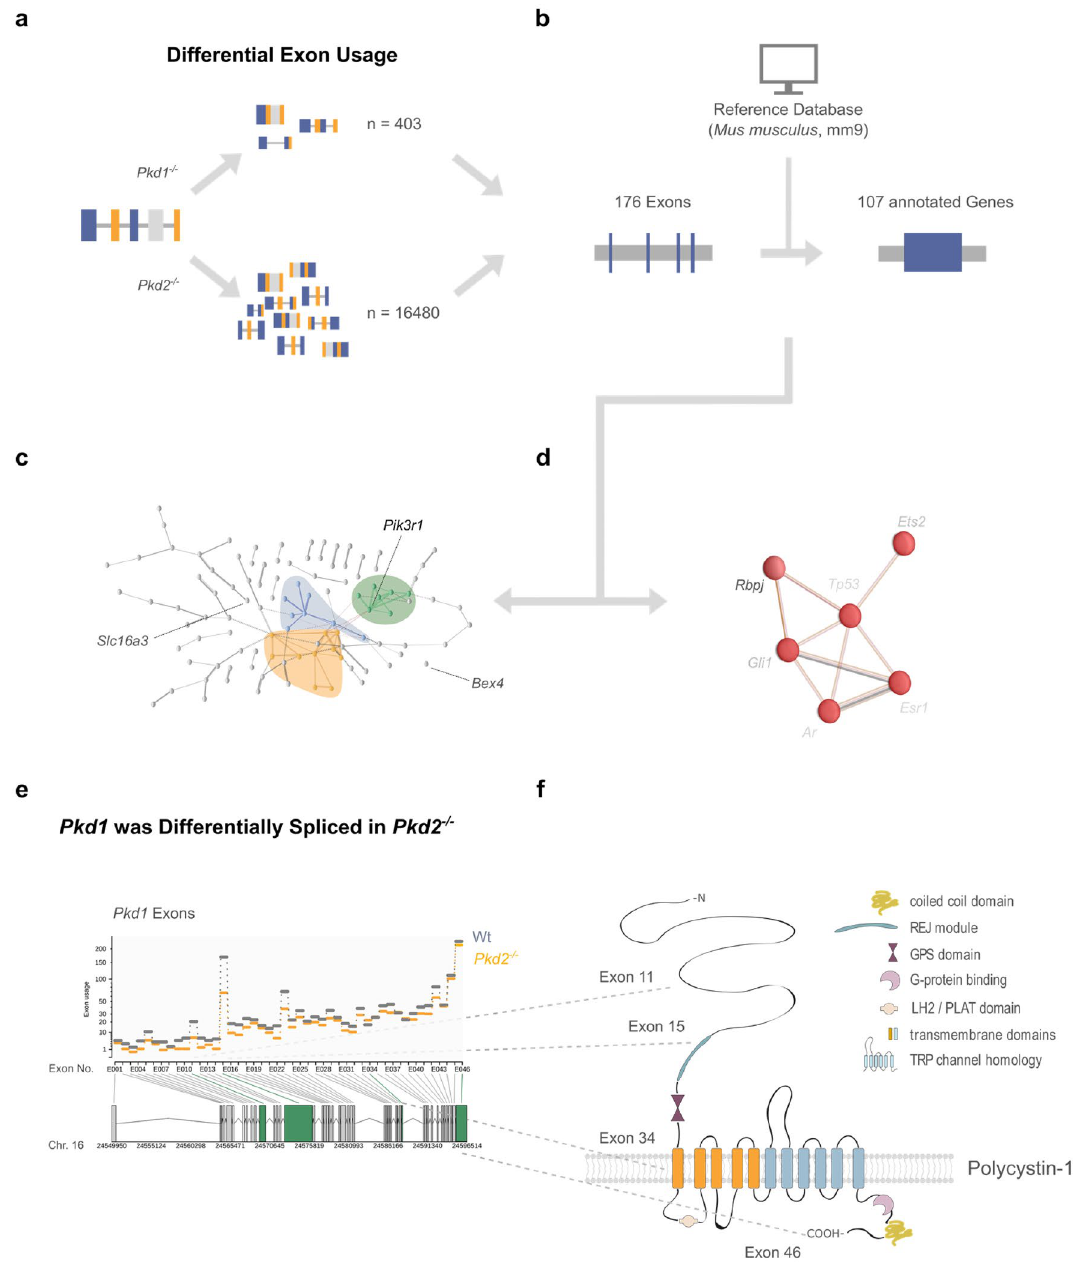
Figure 5. Loss of Pkd1 and Pkd2 caused significant alteration in exon usage, including differential splicing of Pkd1 . ( a ) Differential exon usage in Pkd1 −/− and Pkd2 −/− cells was assessed using DEXSeq 99,100 . Surprisingly, the number of transcripts with differential exon usage compared to wildtype was > 70-fold higher in Pkd2- deficient cells than in Pkd1 −/− cells (n = 16,480 vs. n = 403). ( b ) 176 differentially used exons overlapped between both genotypes. Identified exons mapped to 107 annotated genes and 39 genomic loci without annotation. 107 characterized genes are thus differentially spliced in Pkd1 −/− and Pkd2 −/− cells. ( c ) Within the CD 178 core set of genes with Pkd-dependent mRNA expression, Pik3r1, Bex4 and Slc16a3 showed additional Pkd-dependent alterations in exon usage. Interestingly, Pik3r1 was associated with protein phosphorylation in functional cluster C 7 (Fig. 4c). ( d ) TF 7 transcription factor Rbpj showed differential splicing in Pkd1 −/− and Pkd2 −/− cells. Rbpj activity had been linked to the expression of 4 CD 178 genes: Cdh2, Glul, Mt2 and Spp1 (Fig. 4e). ( e ) and ( f ) further corroborated the functional interdependence of PKD1 and PKD2, Pkd1 exons 11, 15, 34 and 46 showed reduced usage in Pkd2 −/− cells. 4 domains of Polycystin-1 (PC-1) were affected: exons 11 and 15 project to the long extracellular N-terminus of PC-1, with exon 15 being part of the receptor of egg jelly module; exon 34 contributes to formation of the transmembrane domains; and exon 46 forms part of the intracellular